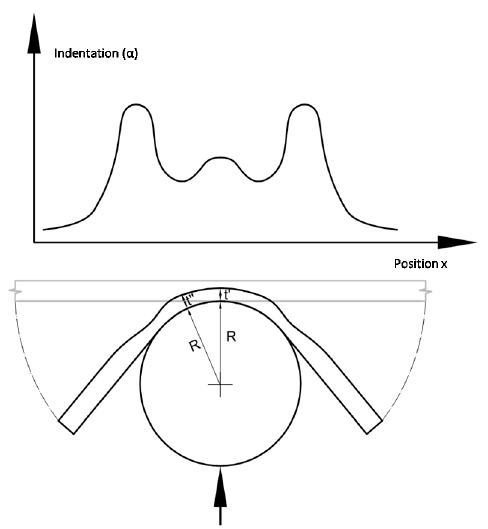
Figure 7. Scheme of the damage contact region when shear is predominant increasing the load applied.